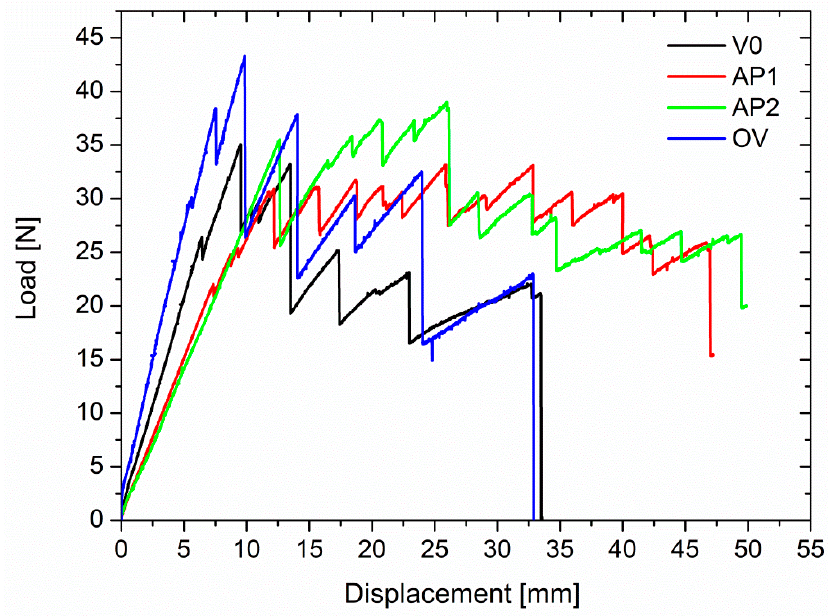
Figure 7. Typical load vs. deflection for the laminates modified with the insoluble veils.